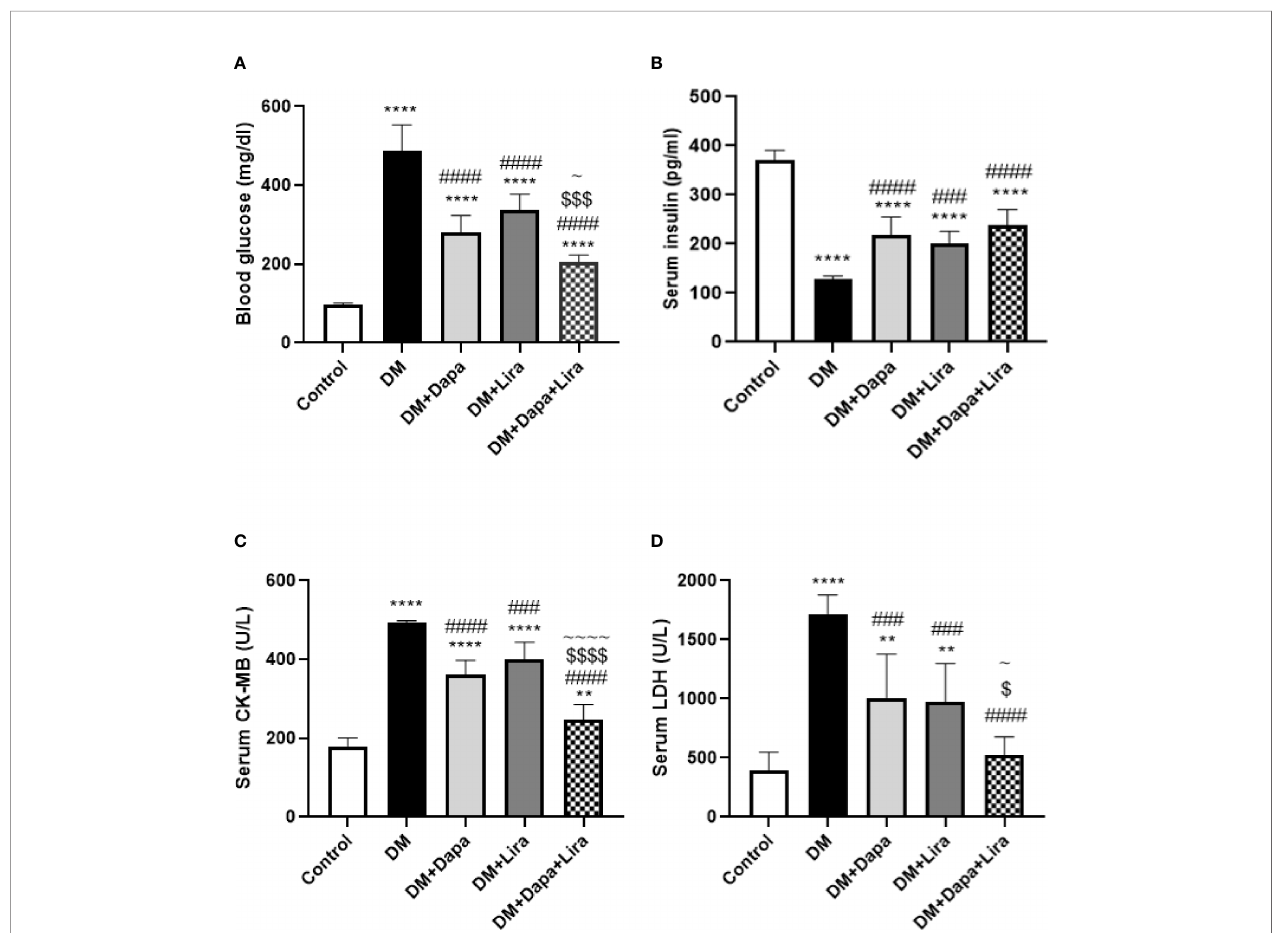
FIGURE 1 | Effect of dapagli fl ozin (Dapa) and liraglutide (Lira) or their combination on (A) blood glucose level, (B) serum creatine kinase-MB (CK-MB), and (C) serum lactate dehydrogenase (LDH). Data are represented as mean ± SE, n = 6. ** signi fi cance in comparison with control group at p < 0.01, **** at p < 0.0001, ### signi fi cance in comparison with diabetic group at p < 0.001, #### at p < 0.0001, ~ signi fi cance in comparison with DM+Dapa at p < 0.05, ~~~~ signi fi cance in comparison with DM+Dapa at p < 0.0001, $ signi fi cance in comparison with DM+Lira group at p < 0.05, $$$ at p < 0.001, $$$$ at p <